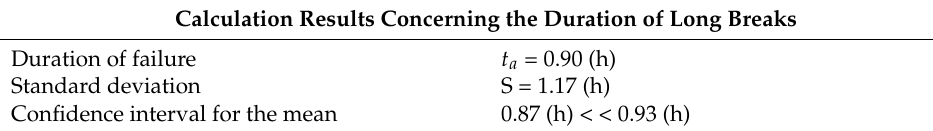
Table 3. Calculation results—long breaks variant.